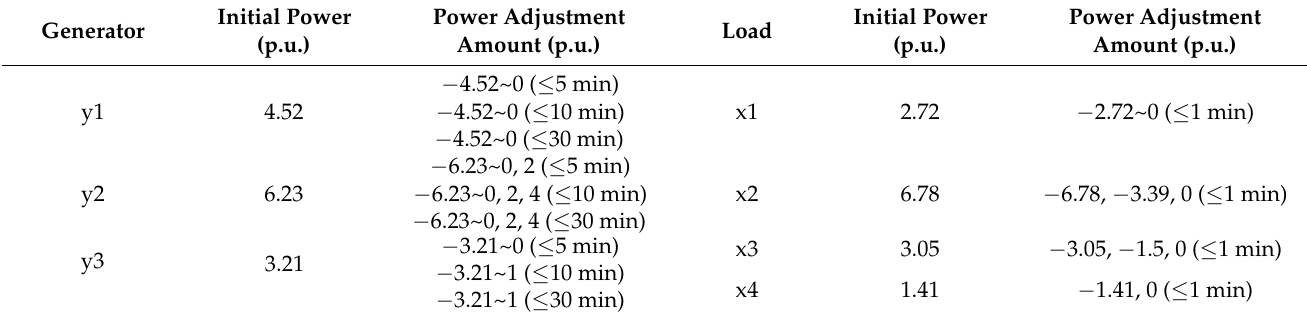
Initial Power Power Adjustment Load (p.u.) Amount (p.u.)